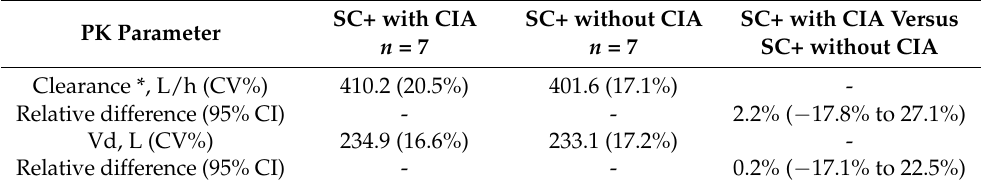
Table 4. Paclitaxel clearance and volume of distribution of patients with CIA versus without CIA in the scalp cooling (SC+) subgroup during one course of paclitaxel